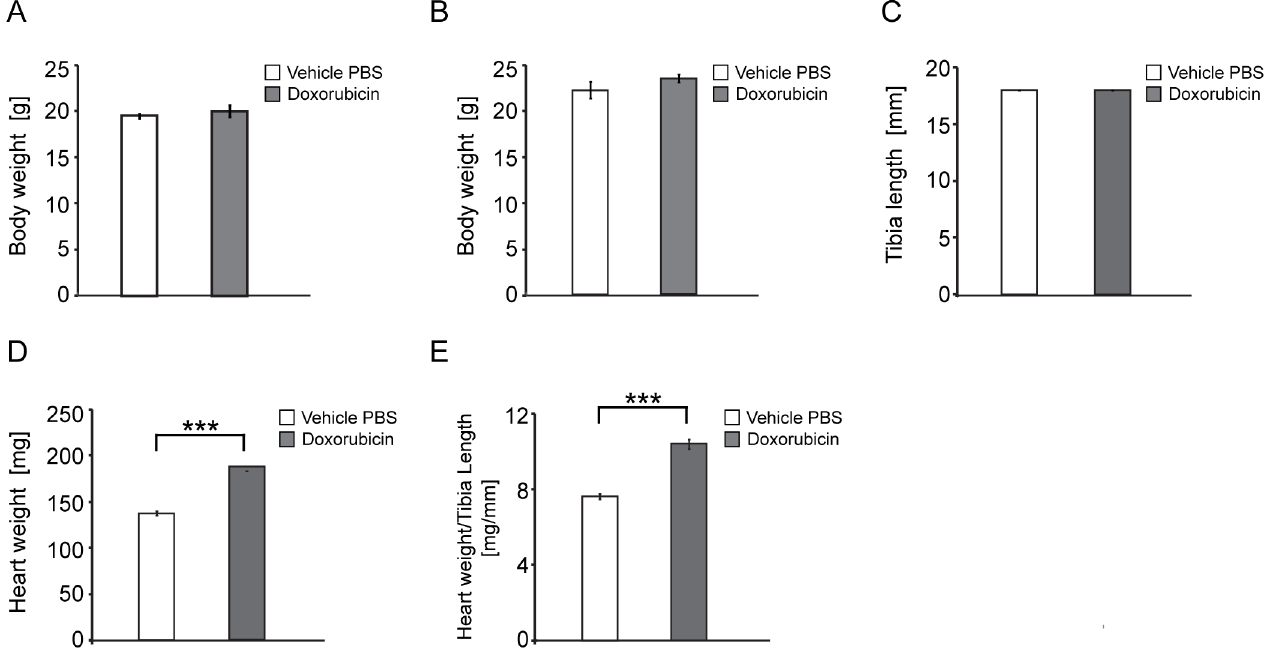
Fig 1. Morphometric analysis of doxorubicin-treated mice. (A) Body weight at 10 weeks of age, prior to implantationof the Alzet pumps. (B) Body weight at the end of the trial (12 weeks of age) (C) tibia length (D) heart weight (E) heart weight to tibia length index. All values are mean ± SEM ( n = 6 WT PBS, n = 6 WT doxorubicin), One-way ANOVA with Bonferroni post-hoc test: * p < 0.05, ** p < 0.01, *** p < 0.001.